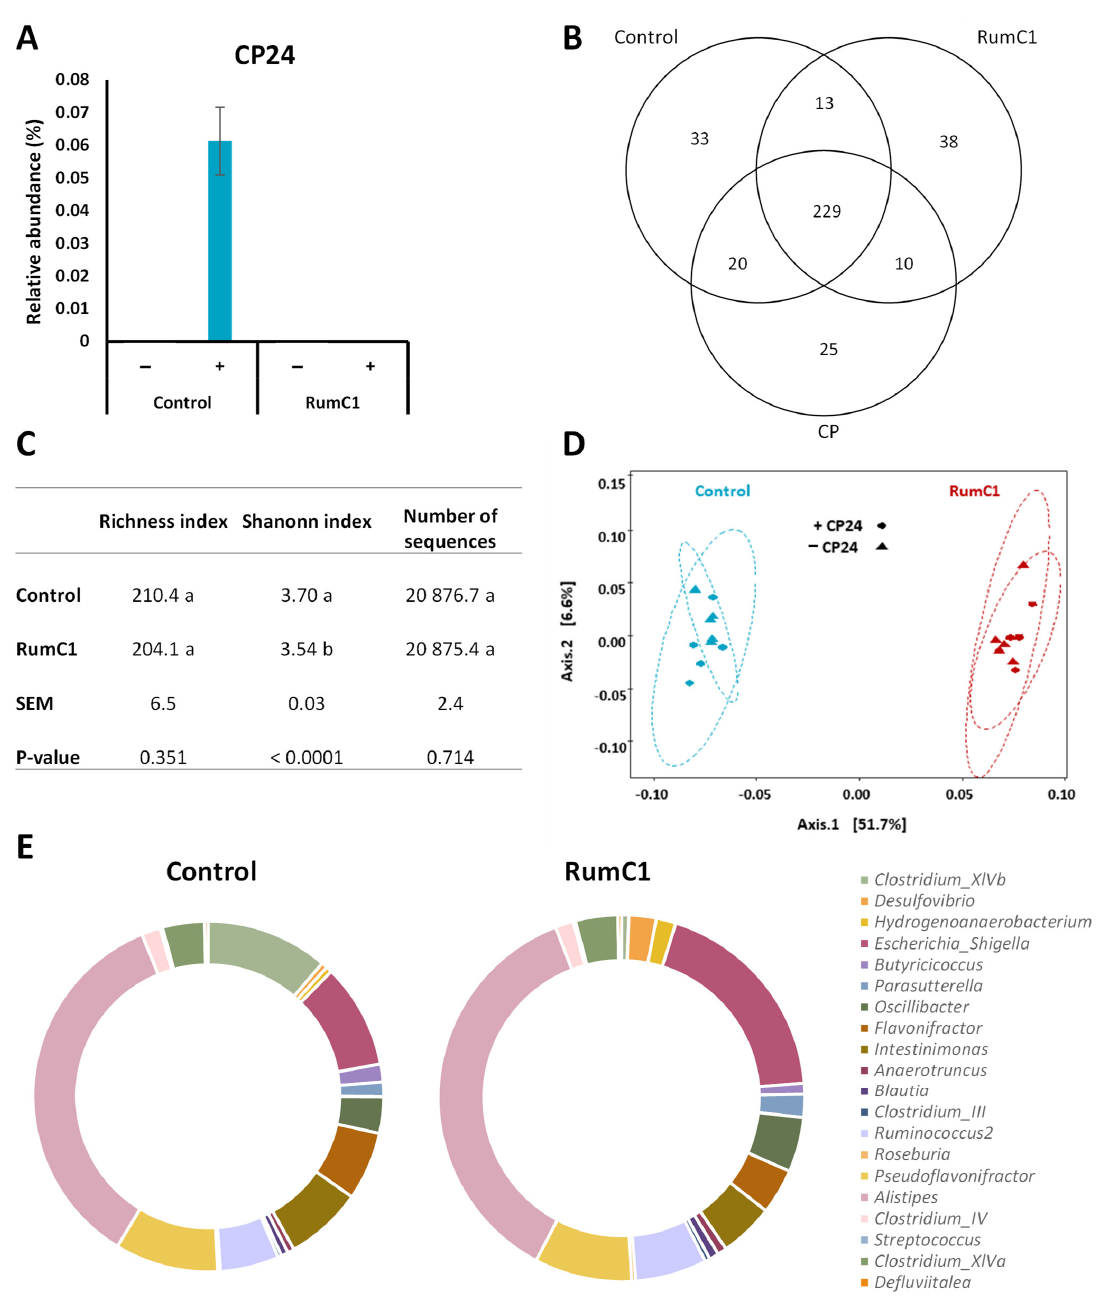
Figure 2. Clearance of C. perfringens by RumC1 in a complex microbial community. The cecal contents of broiler chickens were supplemented with C. perfringens CP24 at 106 CFU/mL (+), or not ( − ), and then with RumC1 at 5 × MIC of C. perfringens CP24 or left untreated (control). Microbial fermentation was then performed in anaerobic conditions for 24 h at 39 ◦ C. The composition of the microbiota from each condition was obtained by 16S rRNA sequencing. Each treatment was done on five replicates. ( A ) Detection of the 16S rRNA gene sequence of CP24 and its relative abundance in the microbial community. ( B ) Venn diagram representing the number of shared or unshared ASVs between the control group (neither CP24 nor RumC1), the cecal contents inoculated with CP24 (group CP, no RumC1), and the cecal contents supplemented with RumC1 (group RumC1, no CP24). ( C ) Diversity index table of the control and RumC1 groups shown in ( B ), SEM = standard error of the mean; a, b: different letters denote significant differences. ( D ) Principal coordinate analysis of the untreated and RumC1-treated cecal contents inoculated with CP24 or not. % in axis shows the degree of explanation (axis 1 explains 51.7% of the variance). ( E ) Major genera and clusters with relative abundance >0.1% composing the microbial communities of untreated and RumC1-treated cecal contents. Inoculation of CP24 does not affect these distributions in each group (control vs.